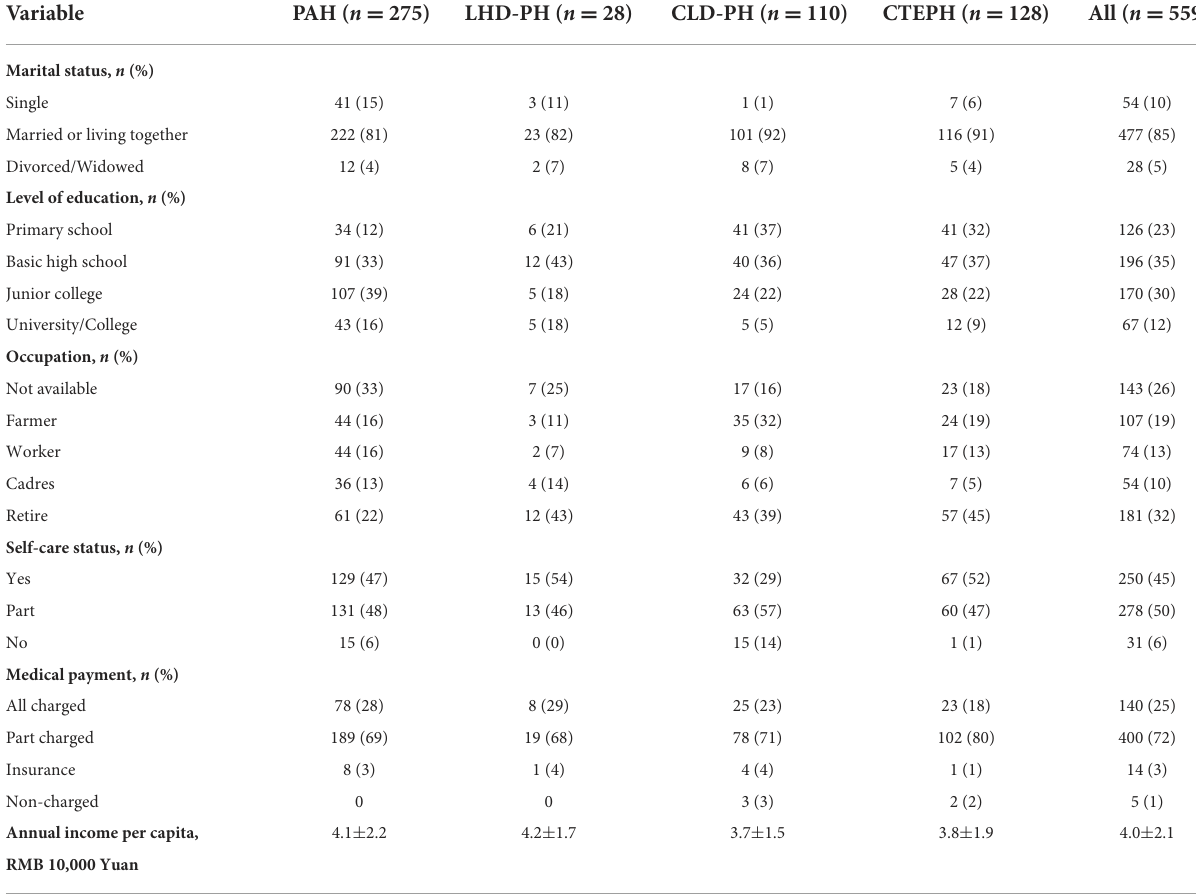
TABLE 2 Baseline social characteristics of patients with main pulmonary hypertension classification.